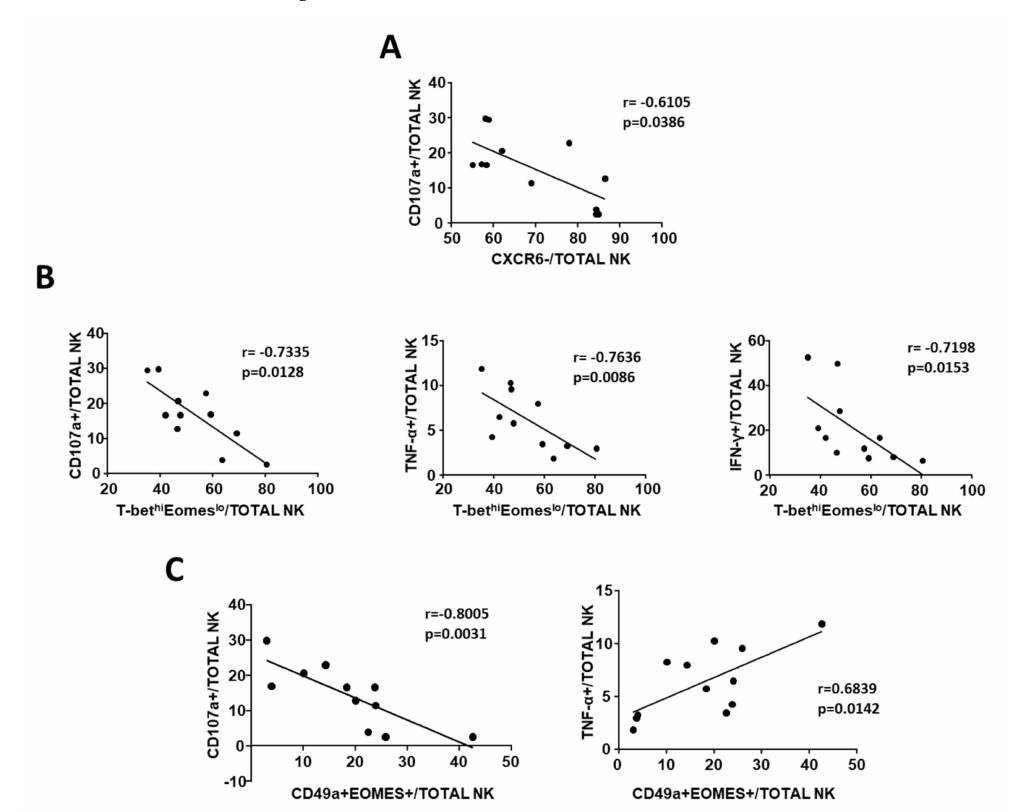
Figure 5. Correlation between phenotypes and TINK function. ( A ). Correlation between frequency of CXCR6 − NK cells and CD107a expression in TINK (n. 12). ( B ). Correlation between percentage of CD107a + , IFN- γ + , and TNF- α + TINK and frequency of T-bet hi Eomes lo NK cells. ( C ). Correlation between frequency of CD49a + Eomes + (regulatory) TINK and degranulation capacity (left) or TNF- α production (right). Statistics by Spearman’s rank order